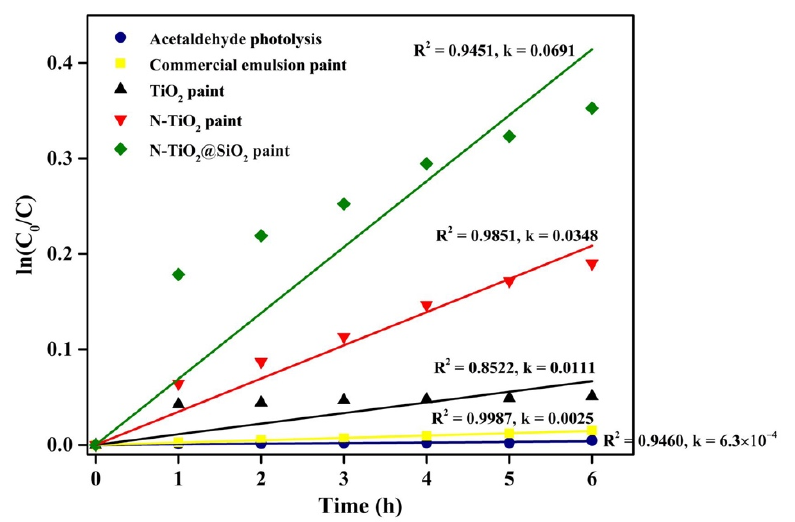
Figure 10. Pseudo-first-order models of gaseous acetaldehyde photodegradation by different photocatalytic paints under LED visible light at room temperature within 6 h.